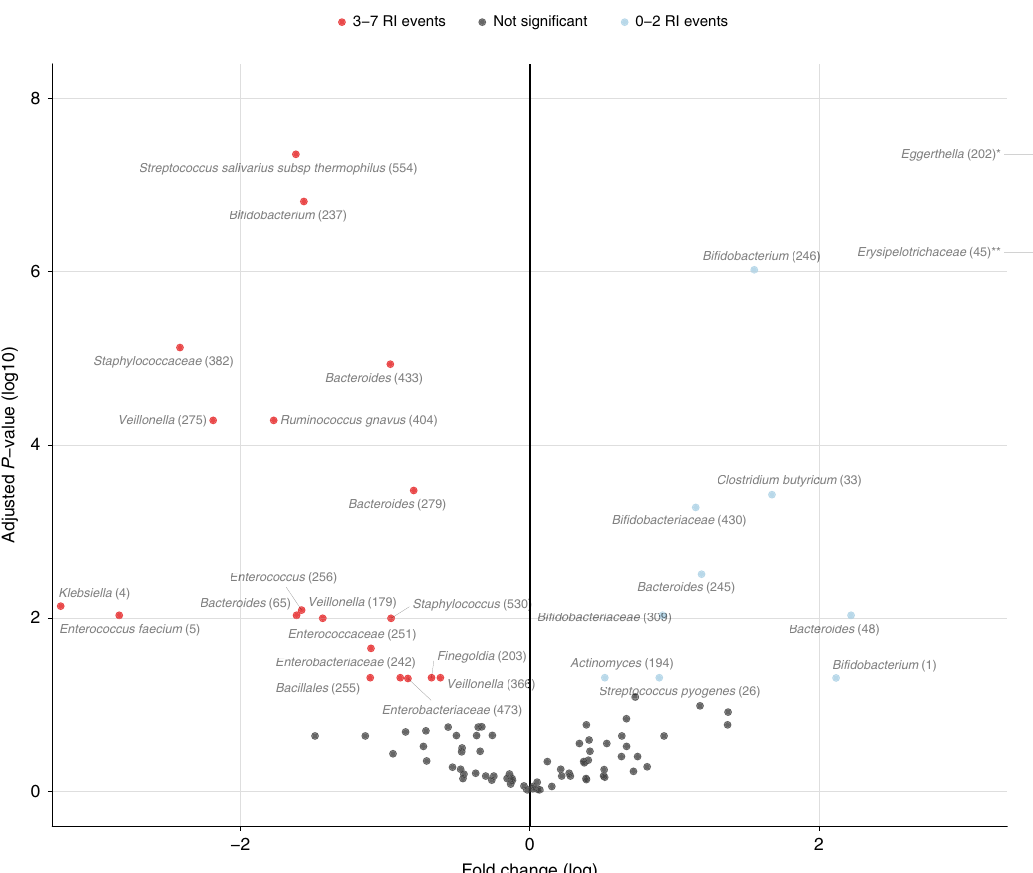
Fig. 5 Differentially abundant taxa between 0-2 vs. 3-7 RI events in fi rst year of life. To identify taxa that were differentially abundant between children experiencing more vs. limited respiratory infection (RI) events over the fi rst year of life, fi tZig analysis was performed on the 119 samples obtained at week 1 with the rare-features- fi ltered OTU-table containing 97 taxa and contrasts set to 0 – 2 vs. 3 – 7 RI events in the fi rst year of life. The blue data points indicate taxa that were signi fi cantly more abundant in children having 0 – 2 RI events, while red points represent taxa that were signi fi cantly more abundant in children with 3 – 7 RI events in the fi rst year of life. The results of two data points falling beyond the limits of the plot: * Eggerthella log2FC 3.512, adjusted p - value (log10) 7.357, ** Erysipelotrichaceae log2FC 6.912, adjusted p -value (log10) 6.222, calculated using a zero-in fl ated Gaussian mixture model.